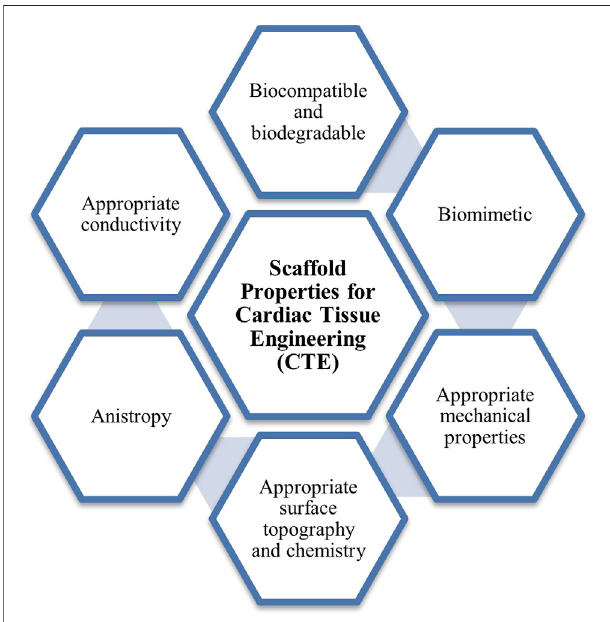
FIGURE 1 | Scaffold properties required for CTE.